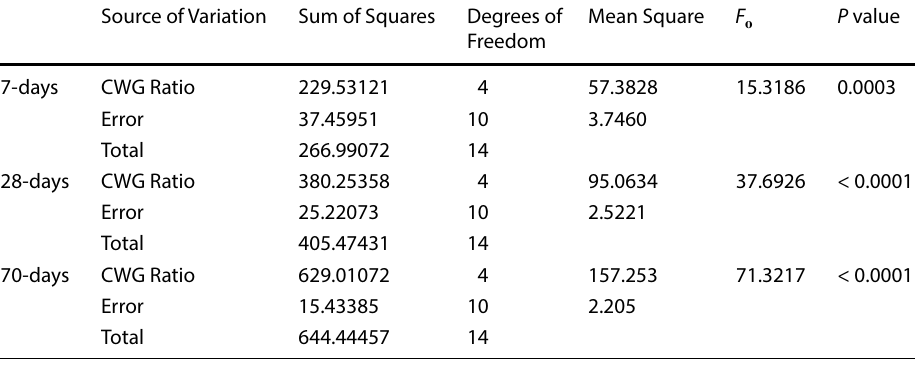
Source of Variation Sum of Squares